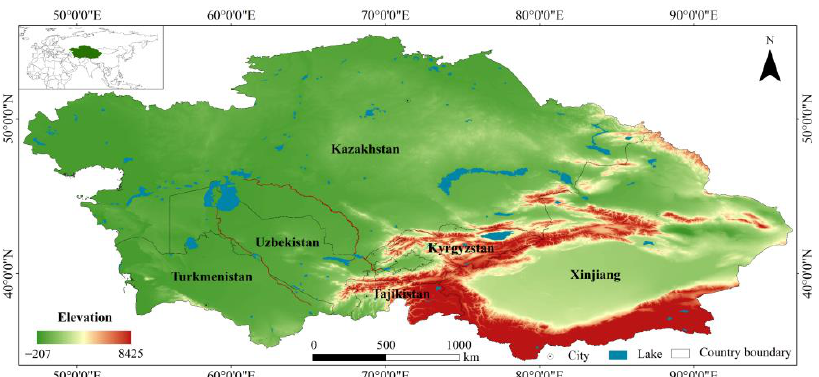
Figure 1. Central Asian region. The world and country borders are from the National Platform for Common Geospatial Information Services (https://www.tianditu.gov.cn/, accessed on 4 May 2022; GS(2021)5443), the lake outlines are from the Natural Earth Data (http://www.naturalearthdata.com/, accessed on 4 May 2022).